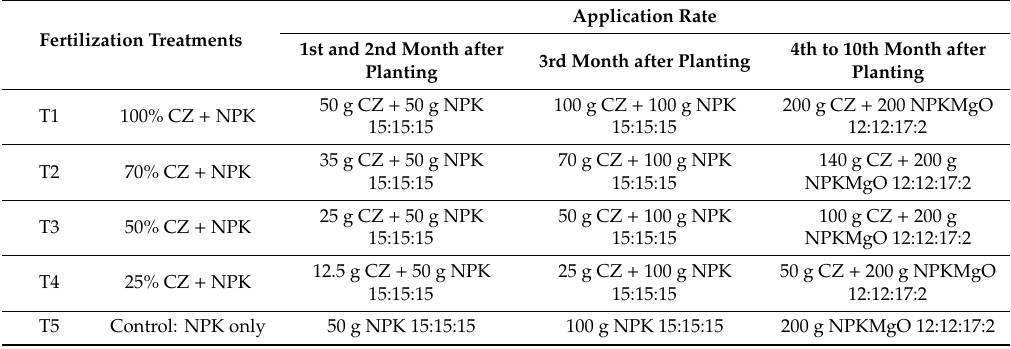
Table 2. Clinoptilolite zeolite and nitrogen, phosphorus, and potassium application rates. Fertilization